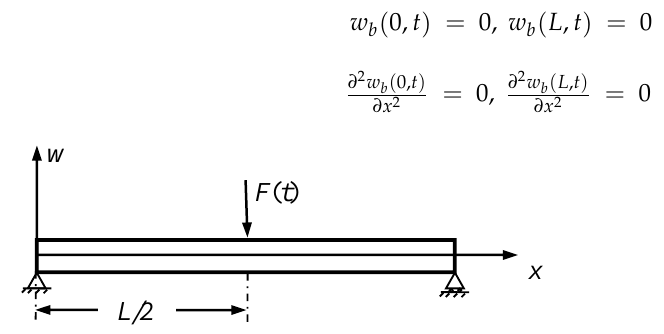
Figure 1. Illustration of a beam configuration.